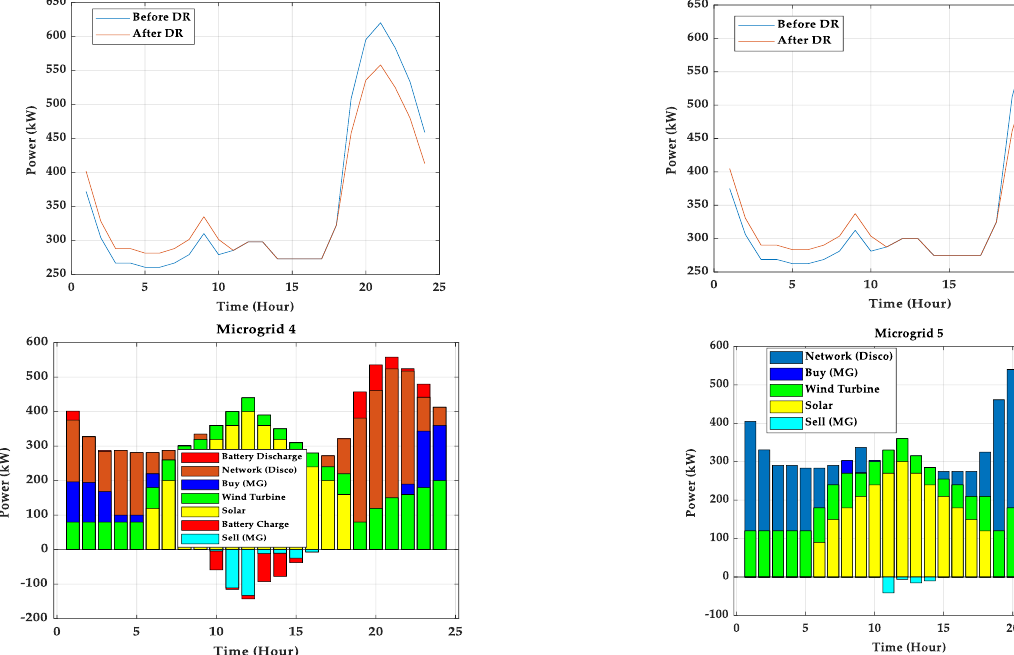
Figure 25. Impact of DR and power-sharing on MGs 4 and 5.